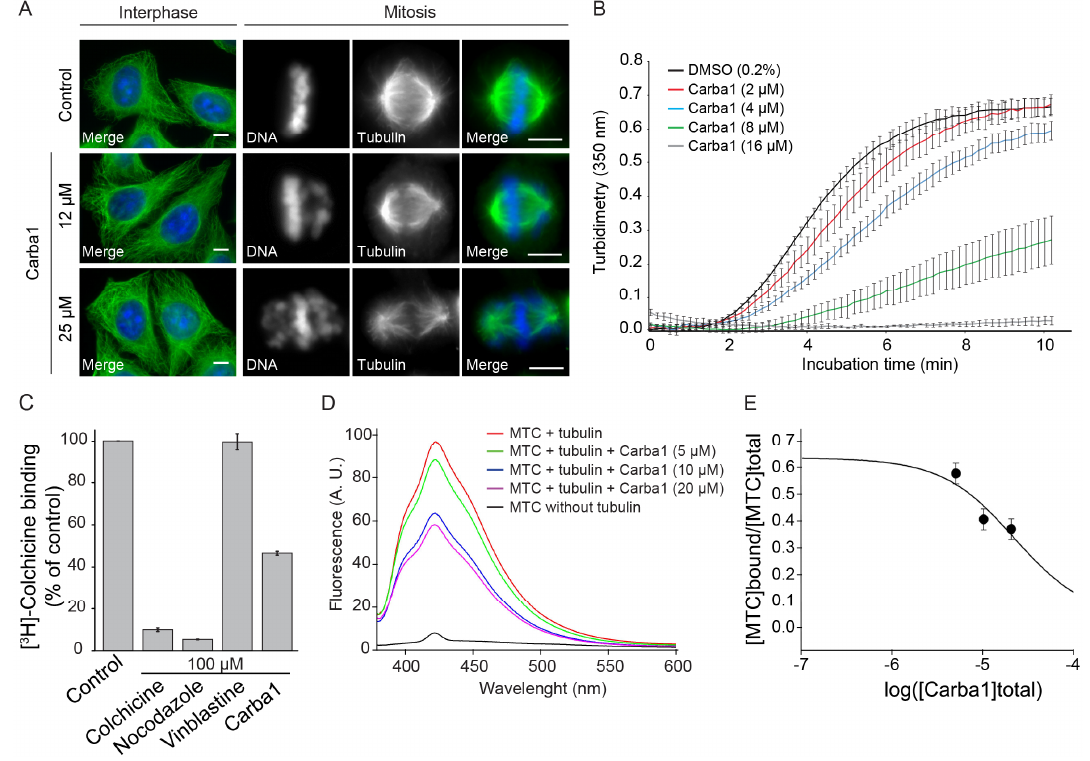
Figure 5. Carba1 is a microtubule-depolymerizing agent that competes with colchicine for tubulin binding. ( A ) Immunofluorescence analysis of the Carba1 e ff ect on interphase and mitotic microtubules (MTs). MTs in interphase (left panels) or in mitosis (right panels) were stained using an anti-tubulin antibody, as described in the methods section. DNA was stained using Hoechst reagent. Bars = 10 µ m. ( B ) Time course of tubulin polymerization at 37 ◦ C in the presence of vehicle (DMSO, black line) and Carba1 at di ff erent concentrations (colored lines) as indicated, measured by turbidimetry at 350 nm. Purified tubulin: 30 µ M in BRB80 bu ff er with 1 mM GTP. Each turbidity value represents the mean ± SEM from three independent experiments. ( C ) E ff ect of Carba1 on the binding of [ 3 H]-colchicine to tubulin. Carba1 (100 µ M) was used to compete with [ 3 H]-colchicine (50 nM) as described in the methods section. Each value represents the mean ± SEM of three independent experiments. Colchicine and nocodazole were used as positive and vinblastine as negative control. ( D ) Displacement of 2-methoxy-5-(2,3,4-trimethoxyphenyl)-2,4,6-cycloheptatrien-1-one (MTC) from the colchicine site. Fluorescence emission spectra of 10 µ M MTC and 10 µ M tubulin in 10 mM phosphate-0.1 mM GTP bu ff er pH 7.0, in the absence or presence of increasing concentrations of Carba1. ( E ) Displacement isotherm at 25 ◦ C of the fluorescent probe MTC (10 µ M) bound to tubulin (10 µ M) by Carba1 (black line and circles). The solid line is the best-fit value of the binding equilibrium constant of the competitors, assuming a one-to-one binding to the same site.